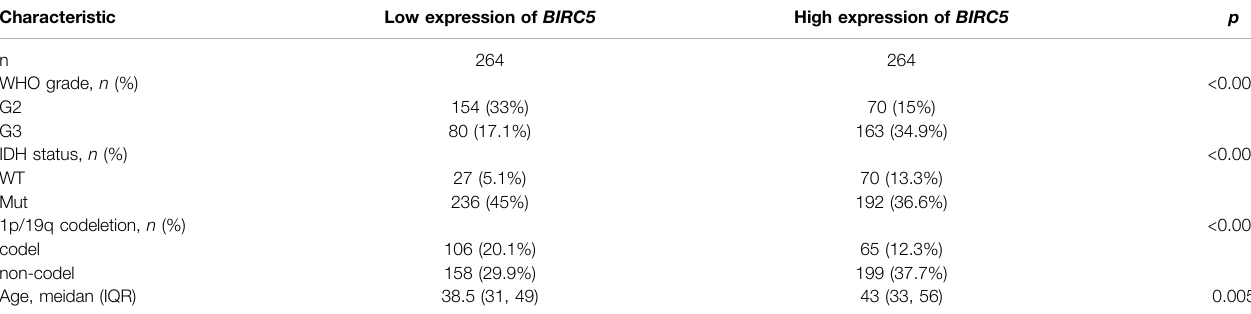
TABLE 1 | Correlation between BIRC5 expression and clinicopathological factors based on the TCGA database.